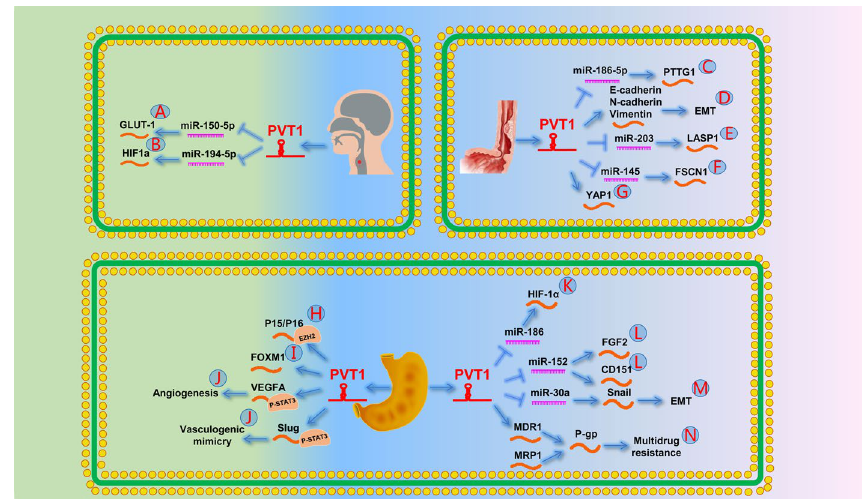
Fig. 2 The role of PVT1 in the digestive system [1]. A PVT1 promotes the expression of GLUT-1 by targeting miR-150-5p. B PVT1 promotes HIF1a by targeting miR-194-5p and leads to cisplatin resistance in OSCC. C PVT1 promotes the expression of PTTG1 by targeting miR-186-5p. D PVT1 can promote the expression of EMT markers (E-cadherin, N-cadherin, and vimentin) in EC cells, indicating that it can promote the occurrence of EMT. E PVT1 promotes the expression of LASP1 by targeting miR-203. F PVT1 promotes the expression of FSCN1 by targeting miR-145. G PVT1 prevents the inactivation of Hippo’s downstream effector YAP1 by reducing its phosphorylation. H PVT1 downregulates P15/P16 expression by recruiting EZH2. I A positive feedback loop between PVT1 and FOXM1 promotes GC growth and invasion. J PVT1 can promote the expression of VEGFA and Slug by binding to STAT3 and ultimately promote angiogenesis and VM. K PVT1 promotes the expression of HIF-1α by targeting miR-186. L PVT1 promotes the expression of FGF2 and CD151 by targeting miR-152. M PVT1 promotes the expression of Snail by targeting miR-30a. N PVT1 promotes GC multidrug resistance by upregulating the ATP-dependent efflux pump P-gp by promoting the expression of MDR1 and